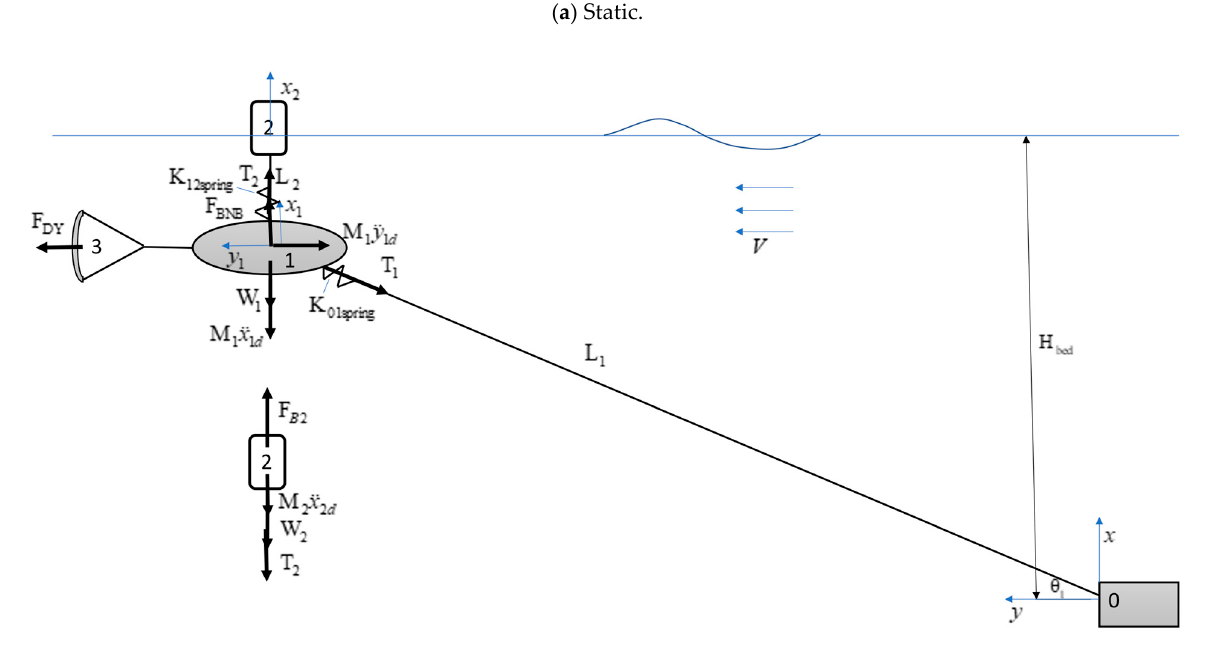
Figure 1. Coordinate of the current energy system composed of pontoon, submarined floater platform, traction rope and mooring foundation.